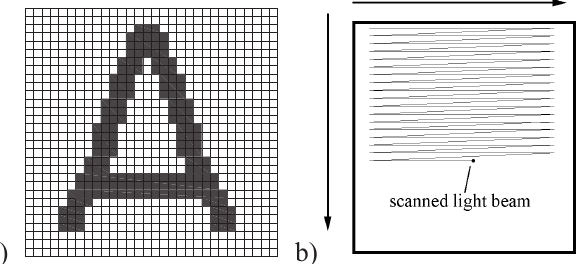
Fig. 1. Display method by raster scanning: a) discrete pixel array, b) light beam